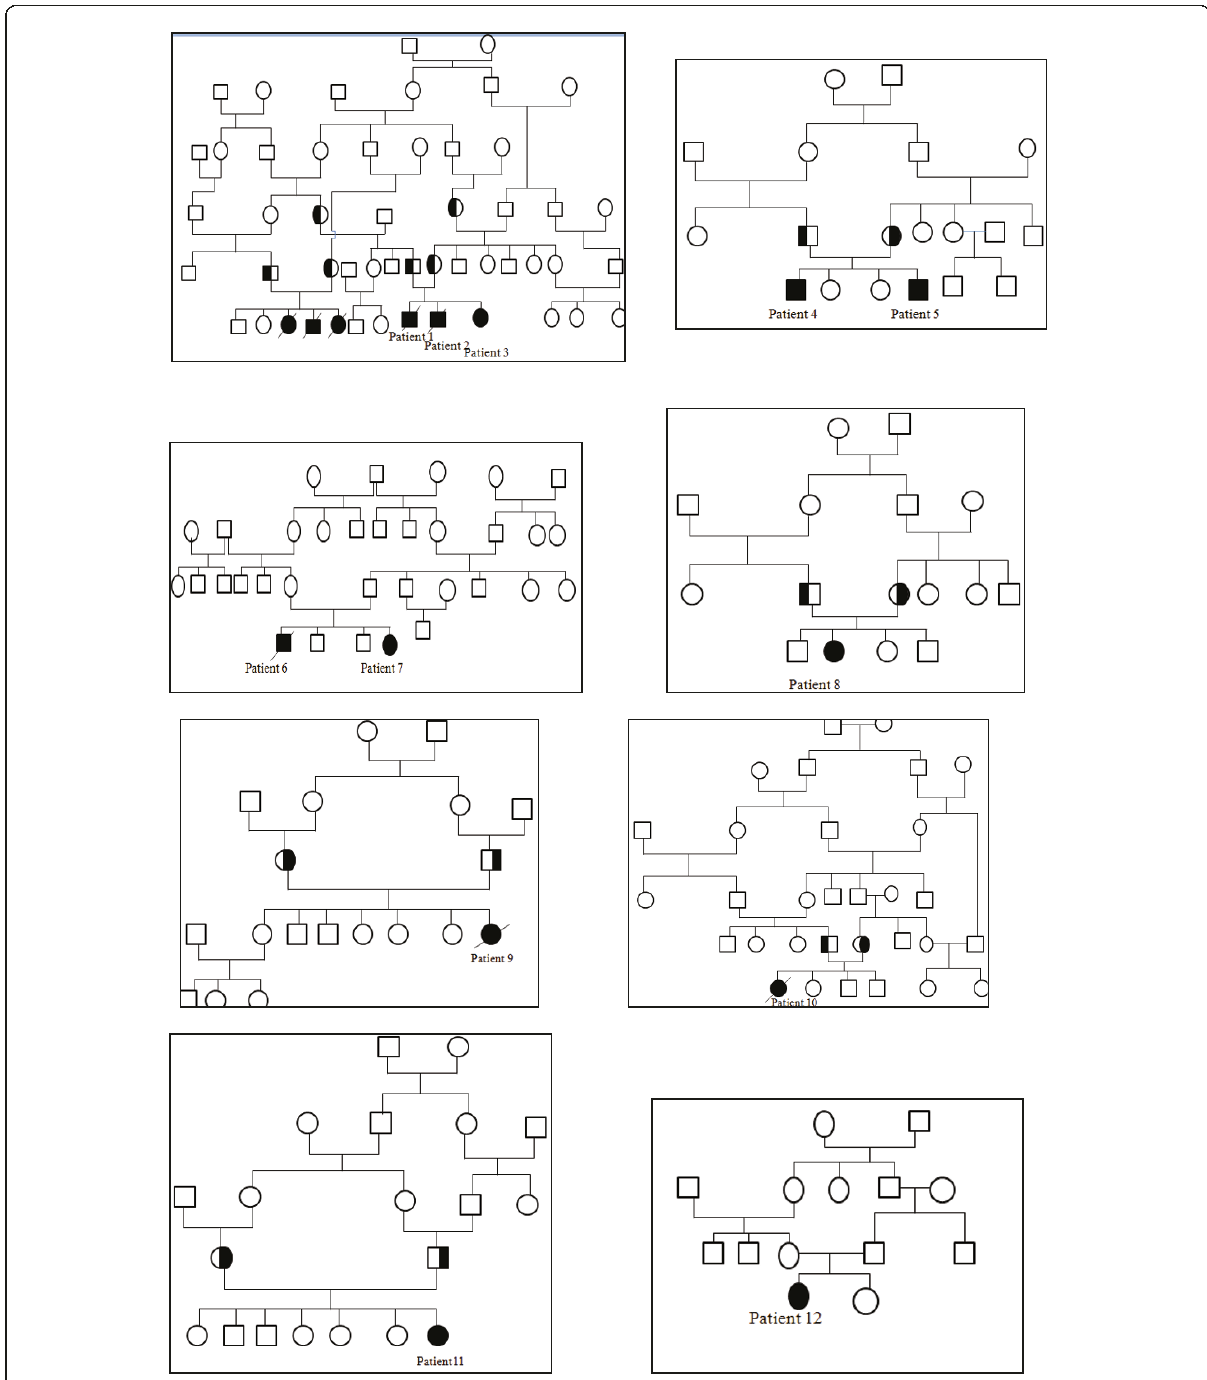
Figure 1 Pedigrees of Tunisian MPS I families